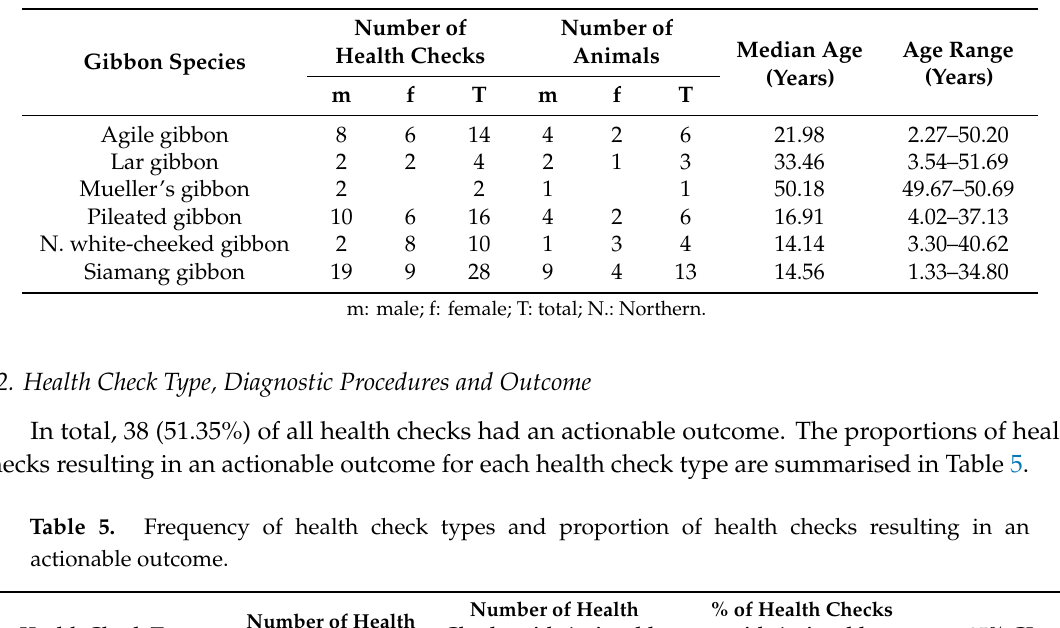
Table 4. Age and sex distribution of gibbon species included in study population.